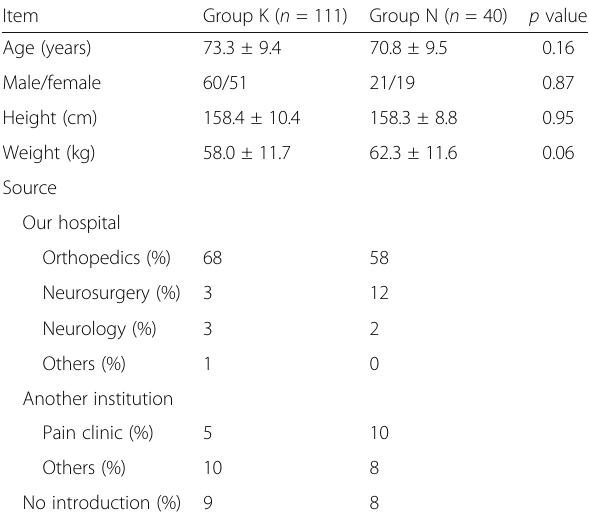
Table 1 Demographic profile and source of referral of the